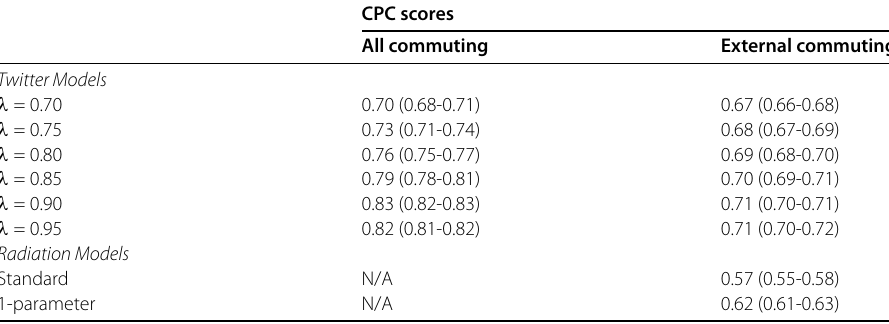
Table 1 CPC scores for comparisons of the Twitter model and the radiation models to commuting data from the census. Brackets contain bootstrapped 95% confidence intervals CPC scores All